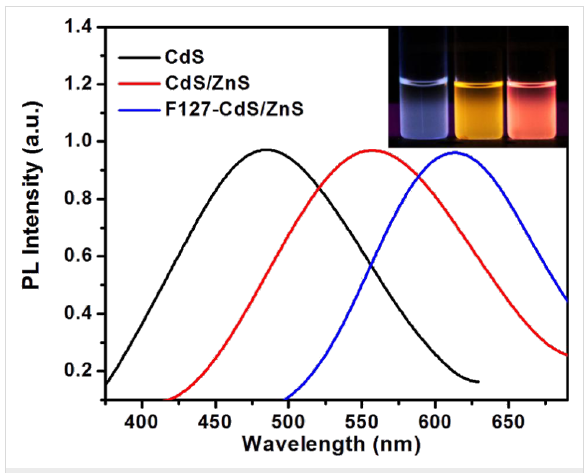
Figure 5: Emission spectrum for three samples.